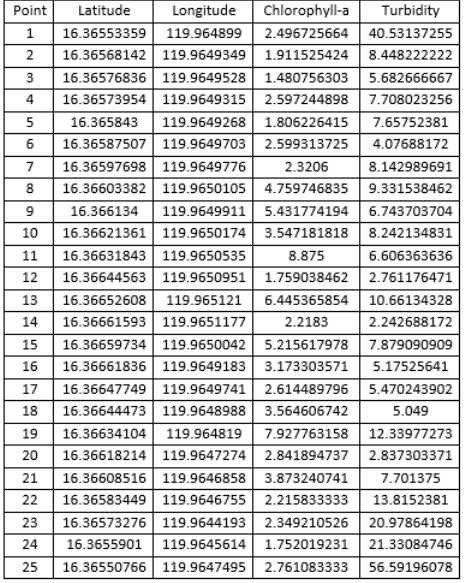
Table 1: Turbidity and Chlorophyll-A values and their corresponding